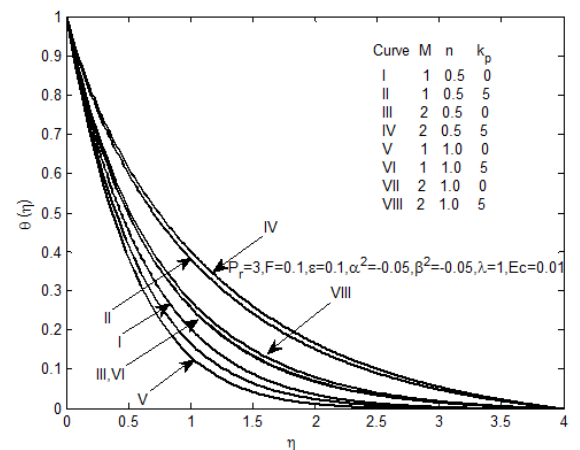
Figure 12: Temperature profiles (PST case)